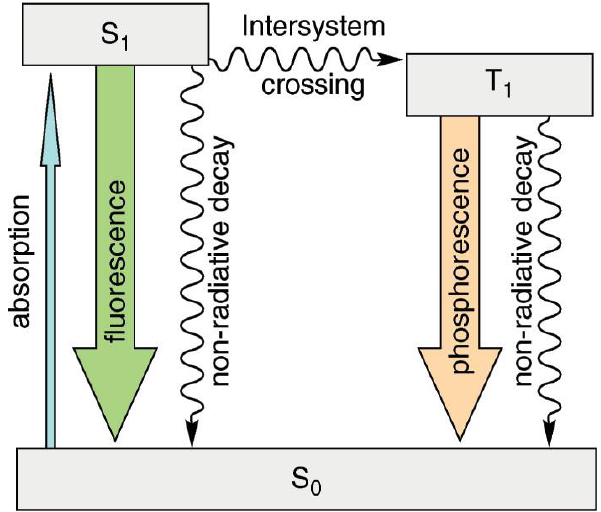
Figure 1. Simplified diagram (Perrin – Jablonski) showing the difference between fluorescence and phosphorescence. Reproduced with permission from reference [7]. Copyright 2011, American Chemical Society.